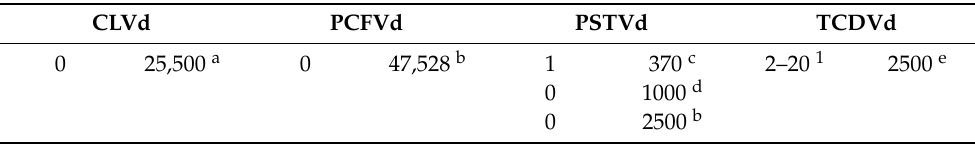
Table 6. The number of infected/raised tomato seedlings in six separate grow-out trials of commer- cially produced seeds reported in the literature and in this